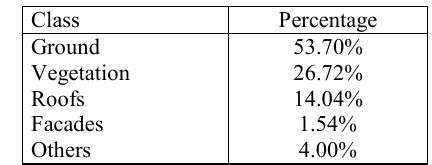
Table 1. Percentage distribution of each class in the